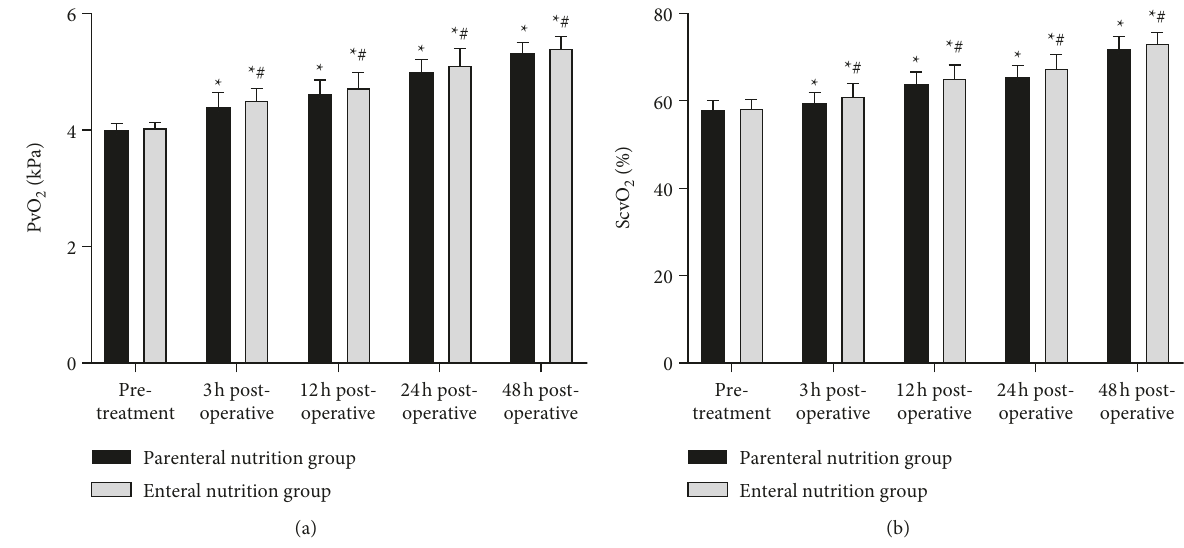
Figure 4: Comparison of oxygen metabolism indexes between two groups. (a) PvO treatment, # comparison with the parenteral nutrition group at the same time point. There is a statistical